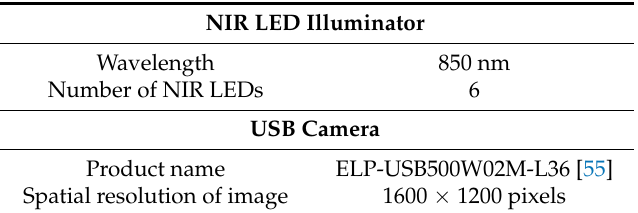
Table 2. Specification of illuminator and camera in our system.